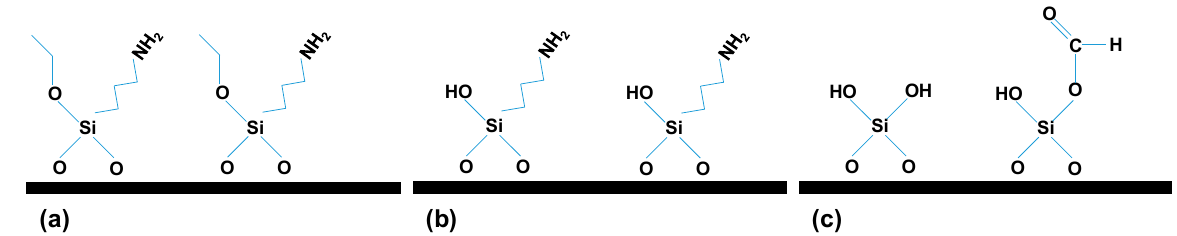
Figure 1. Schematic drawing of the surface reactions taking place during the different steps in a SiO 2 ALD deposition cycle: ( a ) APTES cycle; ( b ) H 2 O cycle and ( c ) O 3 cycle.